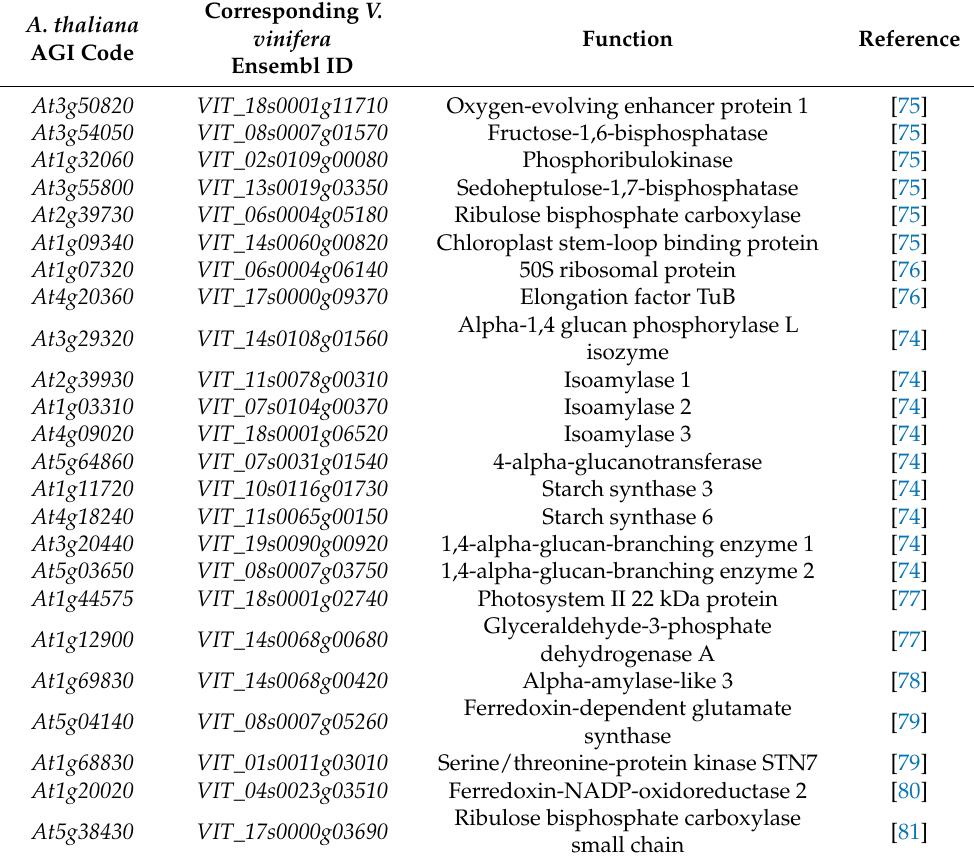
Table 1. Grapevine genes encoding chloroplast-located redox proteins whose transcription is sup- pressed in Furmint berries as noble rot